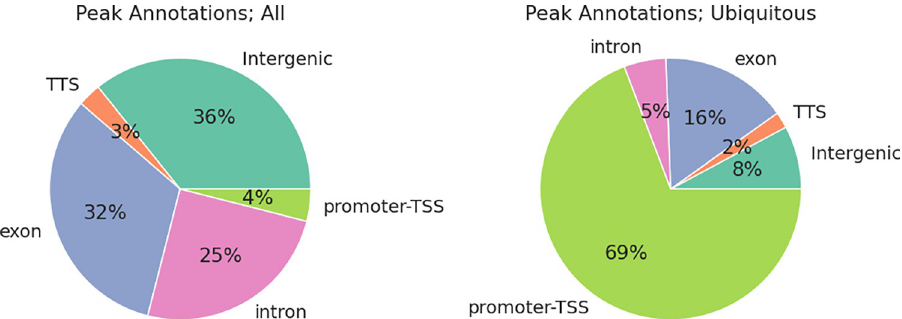
Fig 4. Peak annotations. Left: Composition of peaks by annotation in union peaks; Right: Composition of peaks by annotation in ubiquitous peaks.